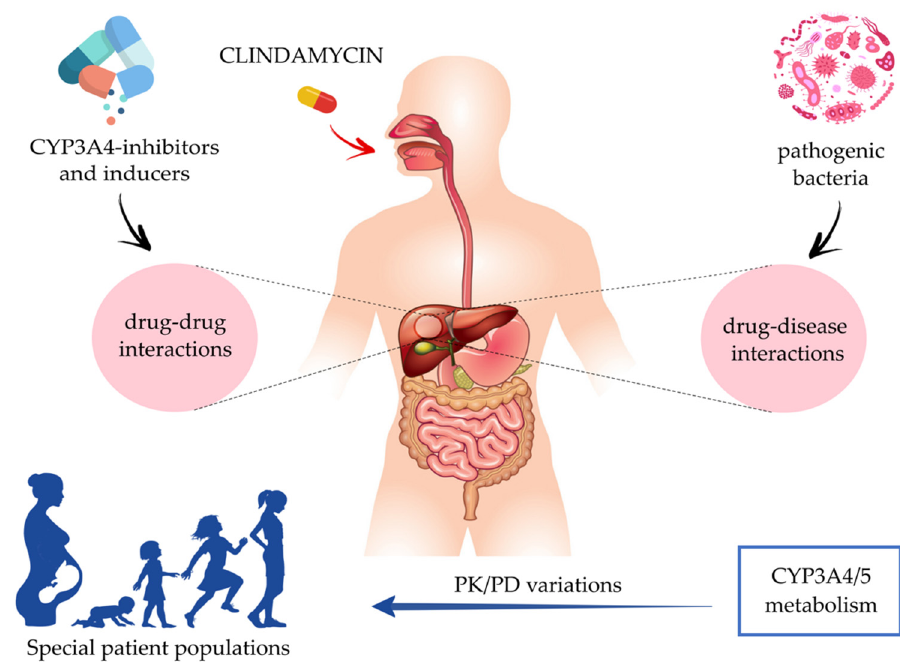
Figure 1. Schematic overview of the main topics addressed in this review.